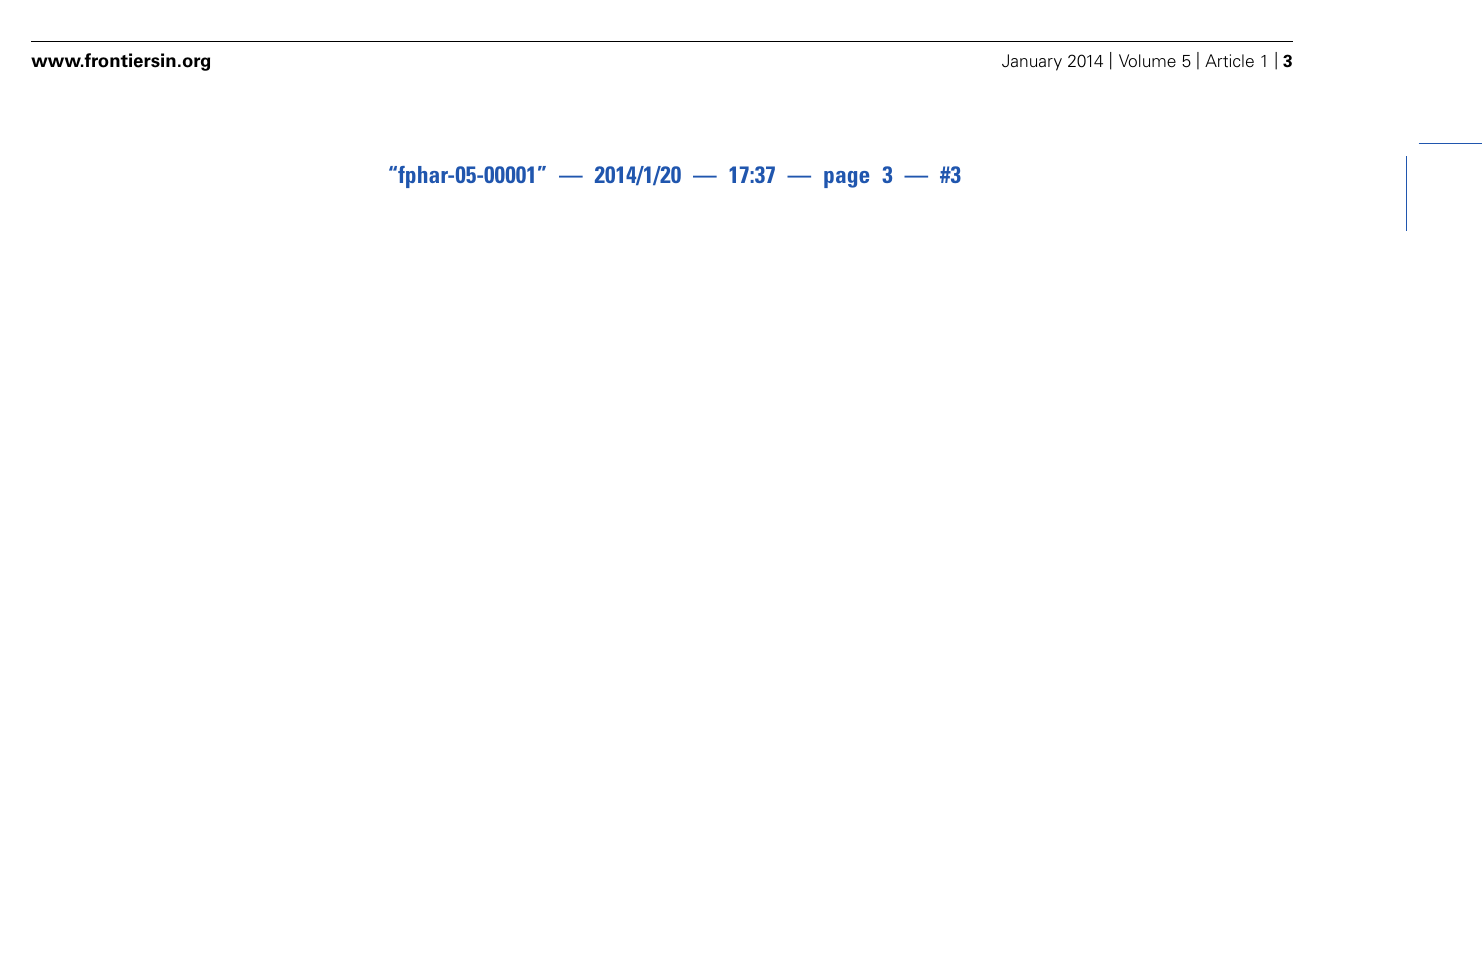
phenomenon associated with actively tissue formation from wound inflammation. The apoptotic immune may drive the conversion of the immune response into a wound healing response, which is characterized by the accumulation of macrophages that promote wound healing and fibrosis through the production of MMPs (including MMP12, tissue inhibitor of metalloproteinases 1 (TIMPs1), growth factors [including platelet-derived growth factor (PDGF)], and cytokines [such as transforming growth factor- β 1 (TGF- β